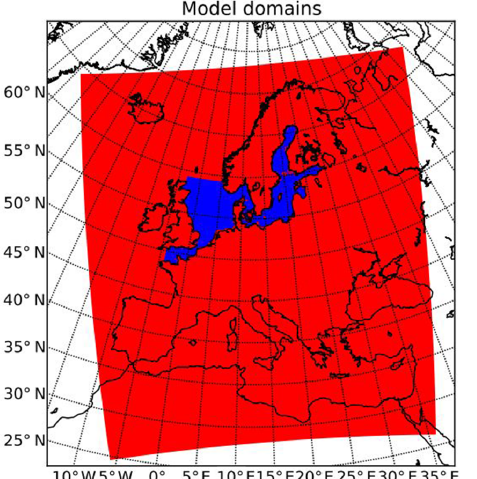
Figure 1. The domain of the NEMO model (in blue) embedded in the RCA European CORDEX domain (in red) (Dieterich et al.,